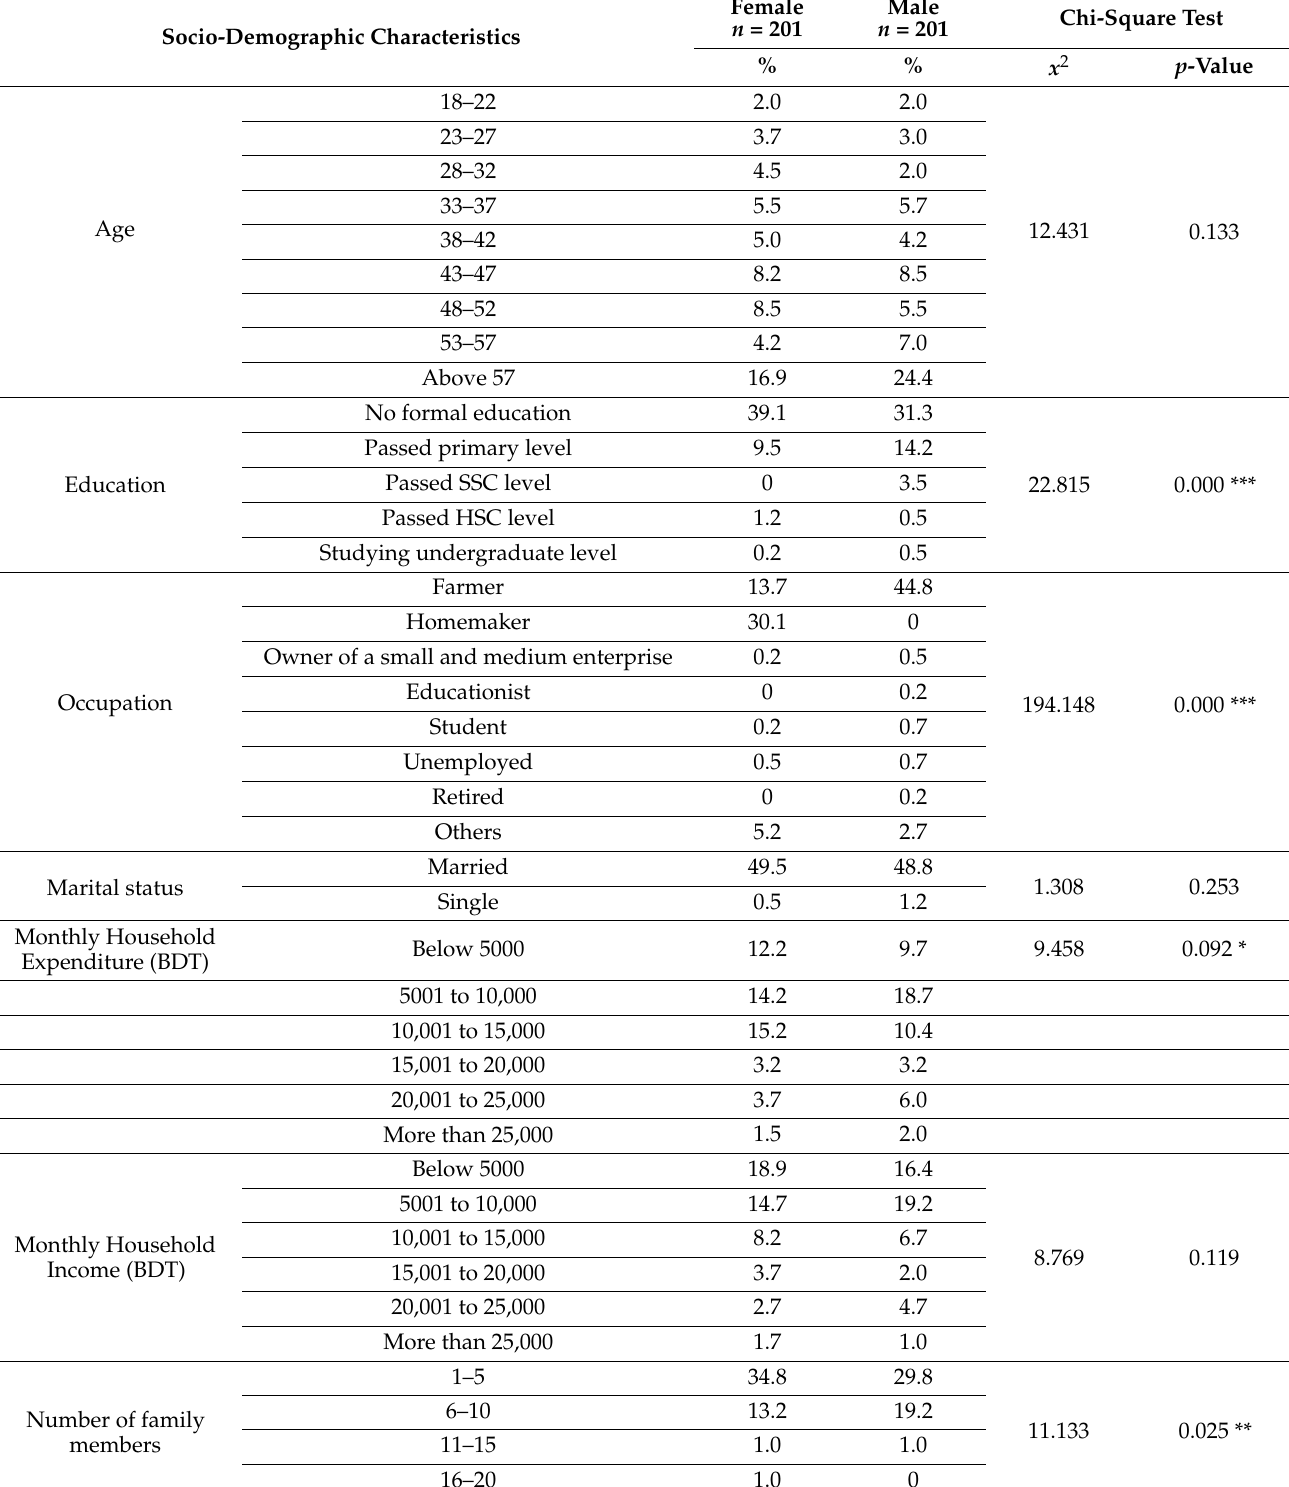
Table 3. Socio-demographic condition of the